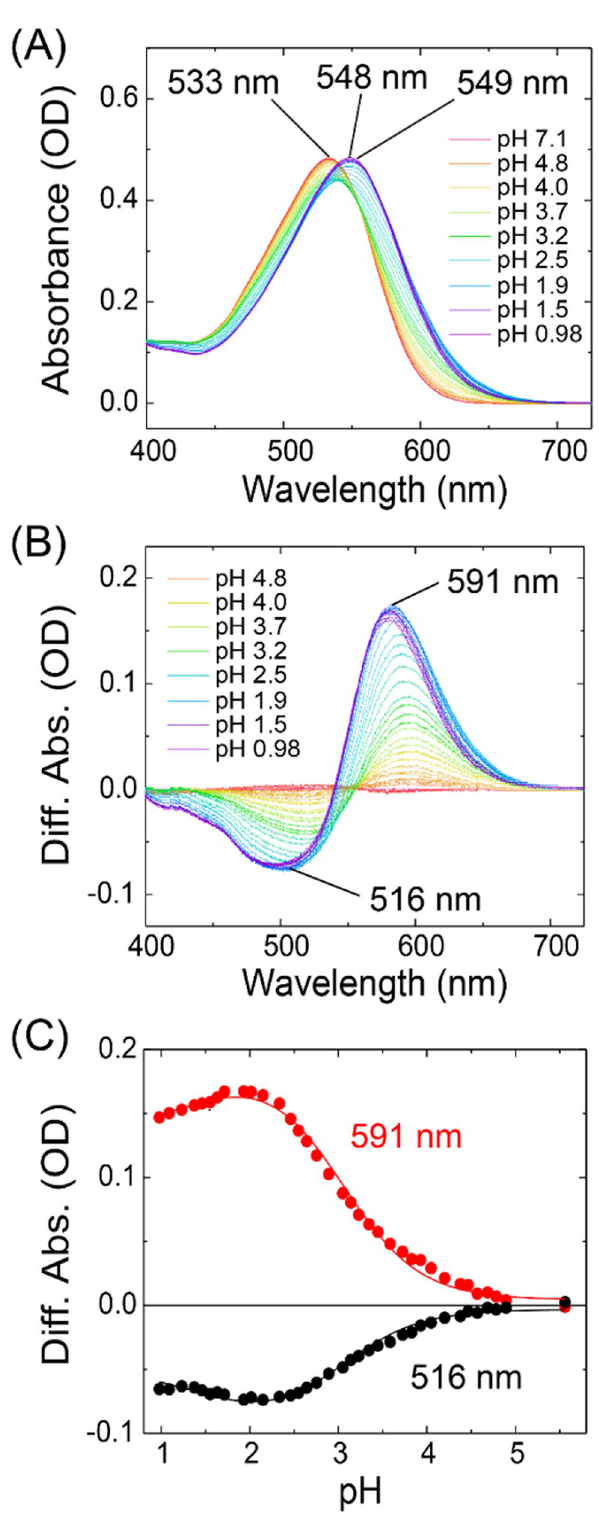
Figure 5. pH titration experiments of Om R2 at acidic conditions. ( A ) Absorption spectra of Om R2 at acidic pH from 7.1 to 0.98 in Buffer A containing 50 mM Tris–HCl, 1 M NaCl and 0.05% (w/v) DDM. ( B ) Difference absorption spectra; each spectrum was obtained by subtracting the spectrum at pH 7.1. ( C ) Plots of the difference absorbance at 516 and 591 nm against the pH values. The titration curve was analyzed using the Henderson–Hasselbalch equation assuming double p K a values (solid